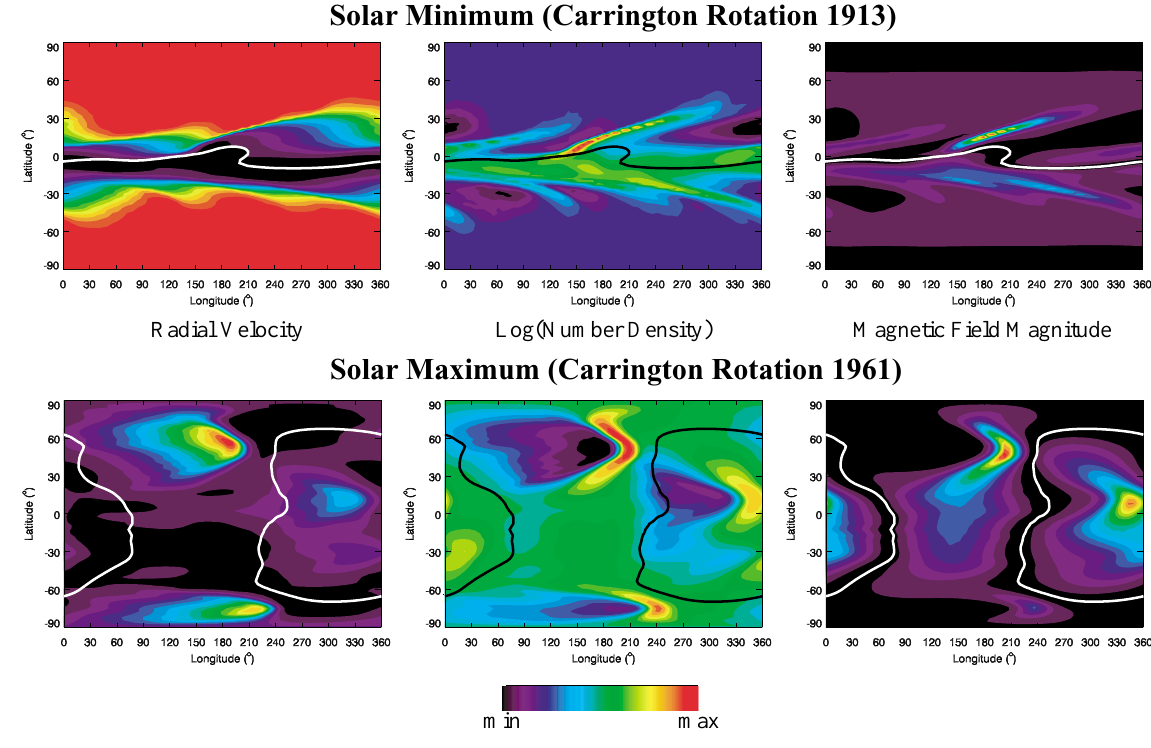
Fig. 8. Comparison of solar wind structure at solar minimum (CR1913) and maximum (CR1961). The heliocentric distance of these slices are 4.35AU and 4.26AU, respectively, corresponding to the location of the Ulysses spacecraft at these times. The columns show speed, density, and magnetic field magnitude. The solid white line in each panel denotes the location of the heliospheric current